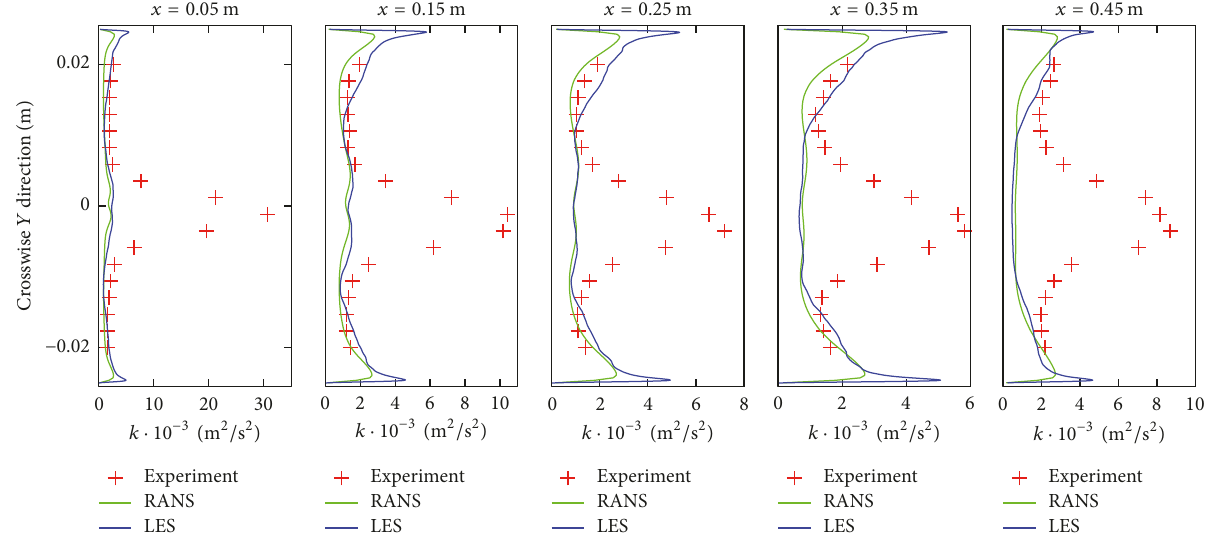
Figure 14: Turbulence kinetic energy profiles at different locations for the two-liquid case.